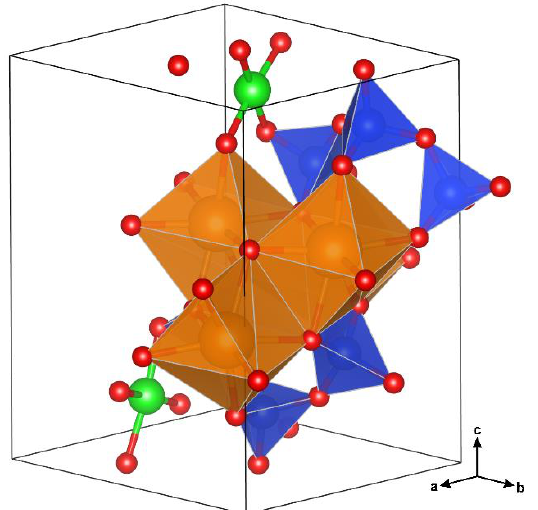
Figure 5. Unit cell content of the Cu-doped Me-S-H single-layer atomistic model showing the position of Ca (orange), Si (blue), O (red) and Cu (green) atoms. The population of single-layer atomistic models of nanocrystals was built from this unit cell along the a and b growth directions.